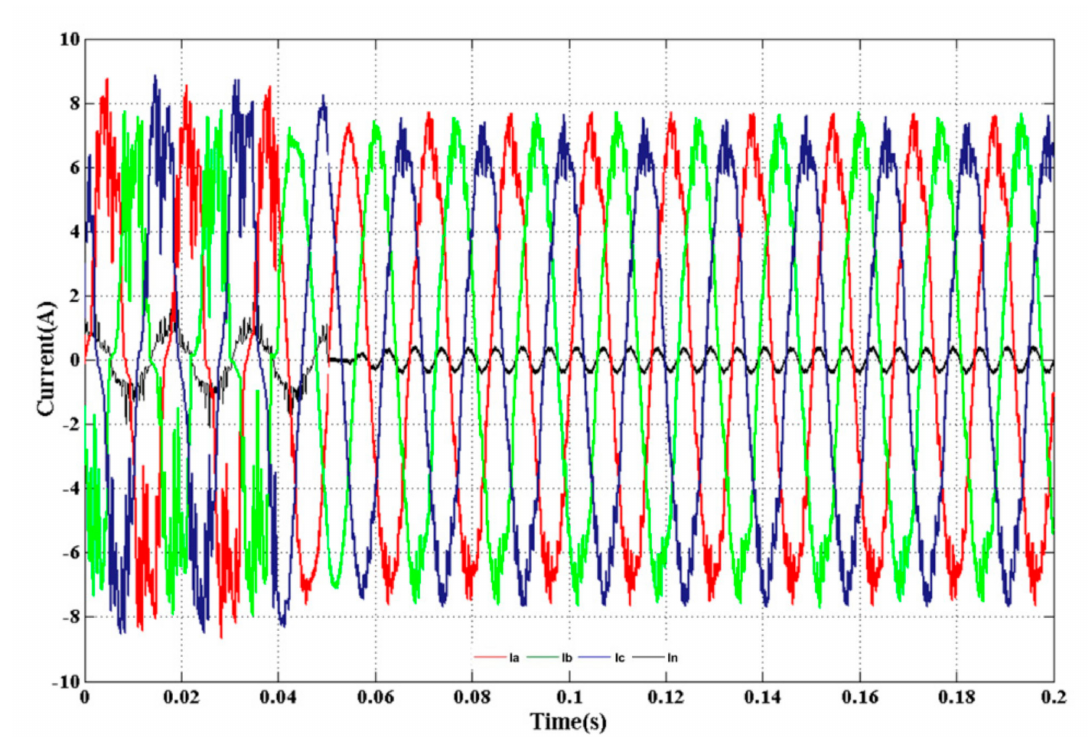
Figure 12. Experimental result of the sliding DFT for case 2.